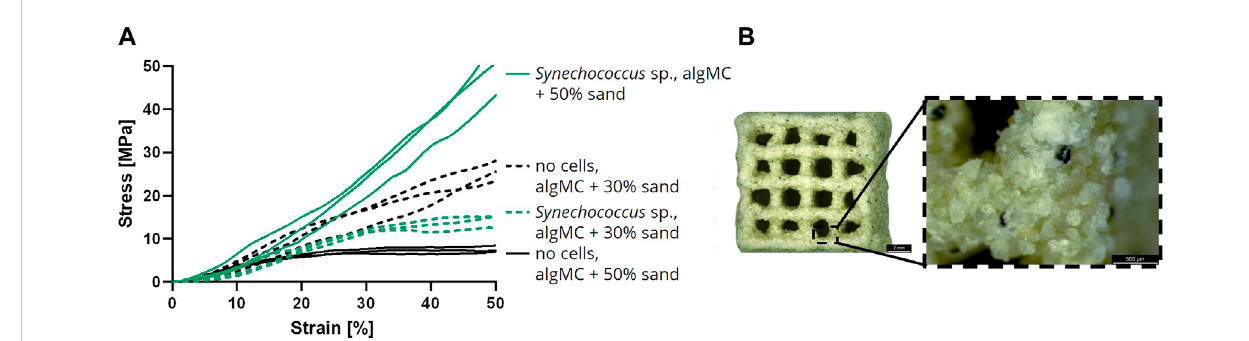
FIGURE 7 (A) Compressive stress over increasing strain of air-dried samples after the cultivation for 7 days in mineralization medium (n = 3). (B) Light microscope image of a dry mineralized sample with PCC 7002 and 50 wt% of sand. Scale bars represent 2 mm (left) and 500 µm